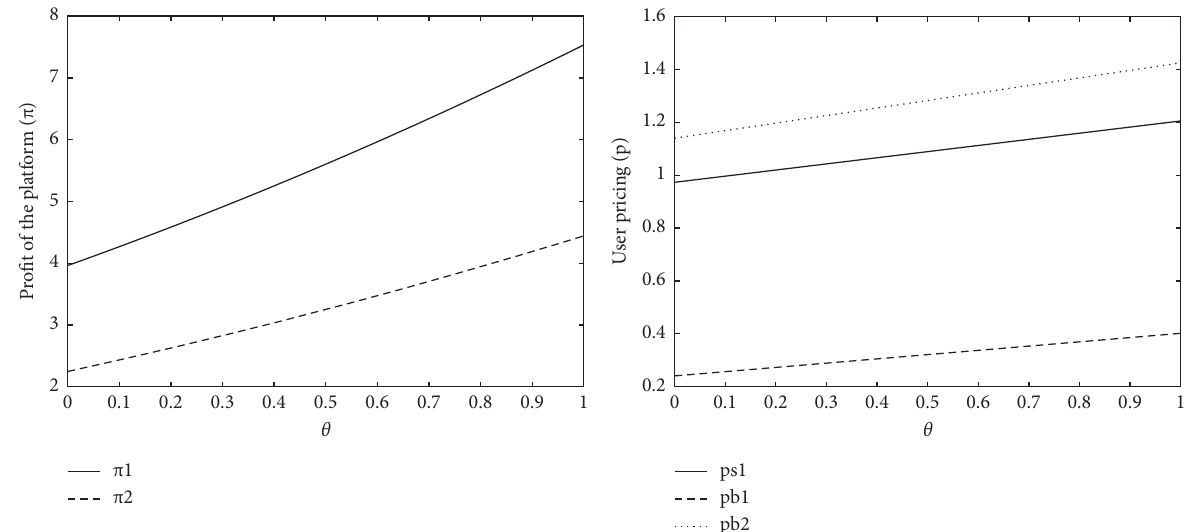
Figure 6: The impact of consumer content quality sensitivity on profits and